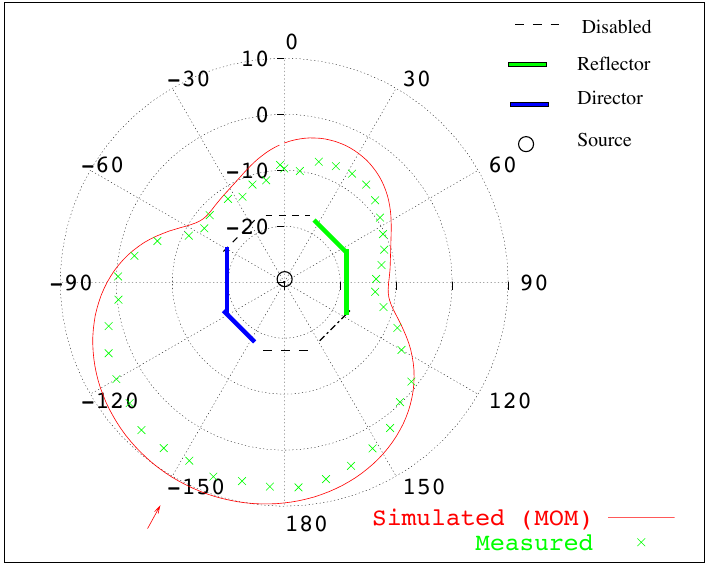
Figure 13. Experimental assessment. Single desired signal, tracking example, impinging direction ( φ = − 150). Beam-pattern ( θ = 90 ) plane.